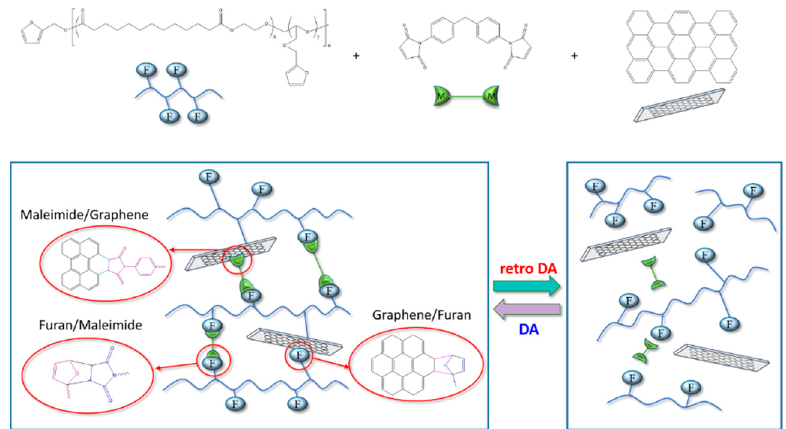
Figure 12. Schematic illustration for the crosslinked structure of the PEBF/graphene/BMI hybrid. This ternary material system offered different diene/dienophile pairs from the furan/maleimide, graphene/furan, and graphene/maleimide combinations to readily induce multiple DA reactions to form a crosslinked network with an uniform distribution of conductive graphene fillers.